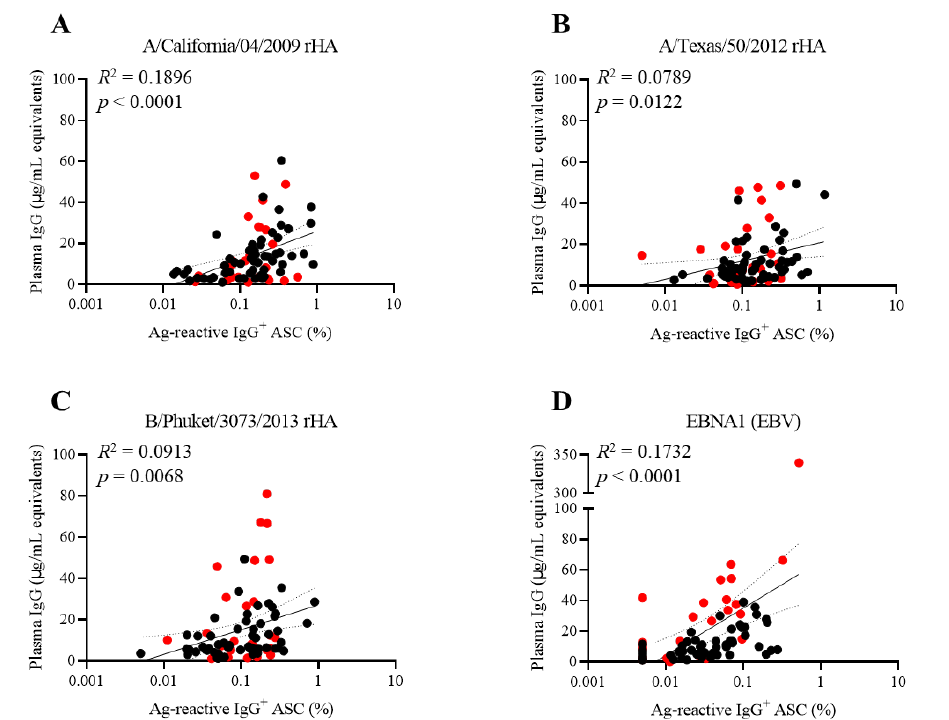
Figure 4. Discordance between circulating antibody levels and memory B cell frequencies in PBMCs for seasonal influenza viruses and EBV. Subjects from the pre-COVID-19 ( n = 54, black dots) and COVID-19 ( n = 25, red dots) donor cohorts were evaluated for IgG + ASCs and circulating IgG reactivity against ( A ) recombinant hemagglutinin (rHA) representing the seasonal H1N1 influenza virus A/California/04/2009, ( B ) rHA representing the seasonal H3N2 influenza virus A/Texas/50/2012, ( C ) rHA representing the seasonal influenza B virus B/Phuket/3073/2013, or ( D ) EBV EBNA1. The frequency of antigen-reactive IgG + ASCs is expressed as a percentage of the total IgG + ASC compartment (x-axis), and the levels of circulating antigen-reactive IgGs are plotted as “µg/mL equivalents” (y-axis) for each subject.